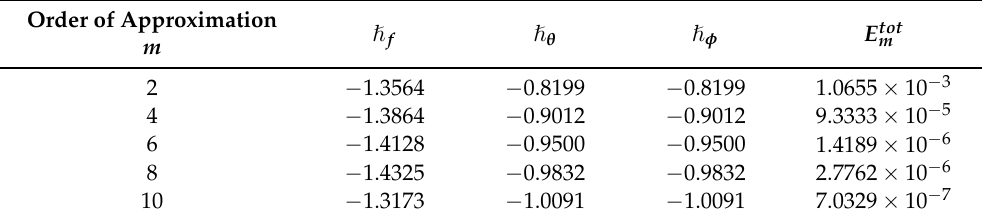
Table 2. Optimal values of convergence control parameters with β = 0.1, λ 2 = 0.2, Pr ef f = 1.0,